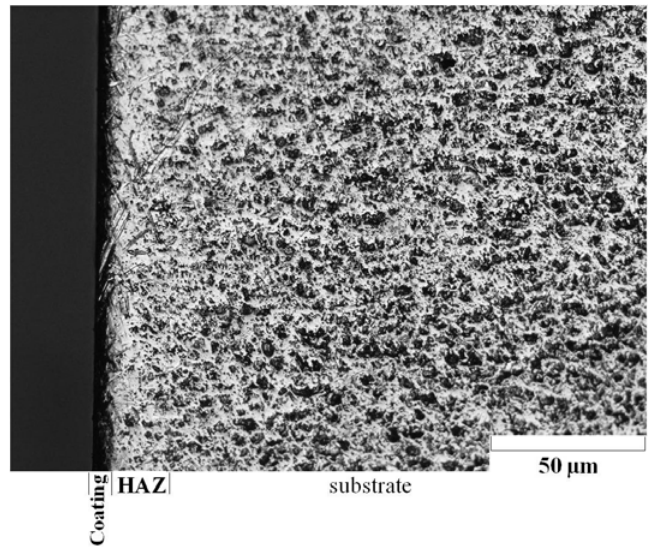
Figure 5. Optical micrograph of coated specimens with code of AFD150530.